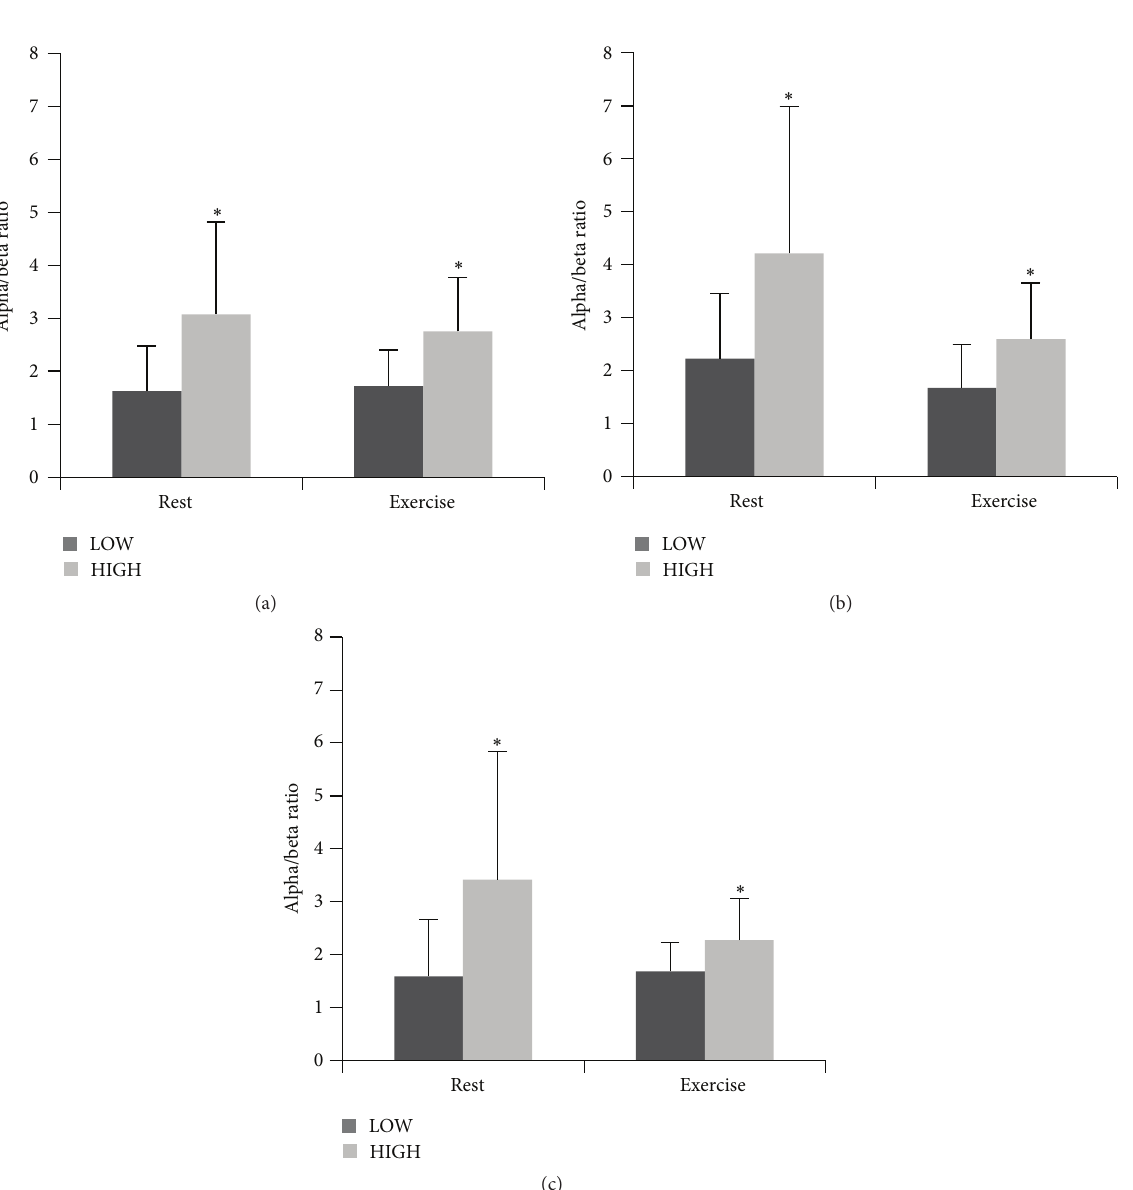
the resting state. Furthermore, alpha/beta ratio was signifi- cantly different between HIGH and LOW at all electrode sites (Figure 1) in both the resting state (frontal: 𝑇(28) = −2.86 ; 𝑝 = 0.008 ; central: 𝑇(28) = −2.52 ; 𝑝 = 0.018 ; parietal: 𝑇(28) = −2.67 ; 𝑝 = 0.013 ) and the exercise condition